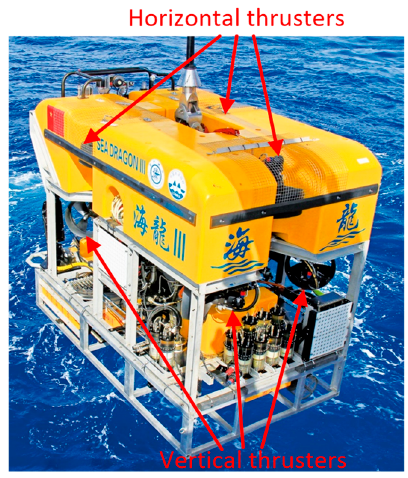
Figure 1. The Sea Dragon remotely operated vehicle (ROV) at sea. Table 1. Main parameters of the ROV.